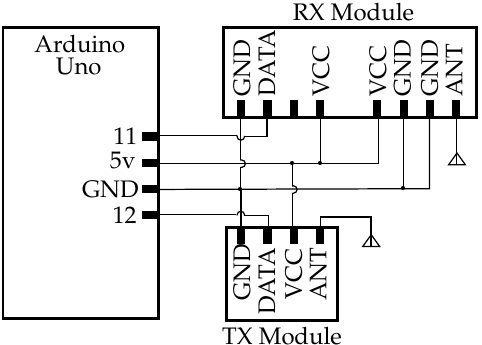
Figure 3. The wiring between the Arduino and the RF modules that implements the device